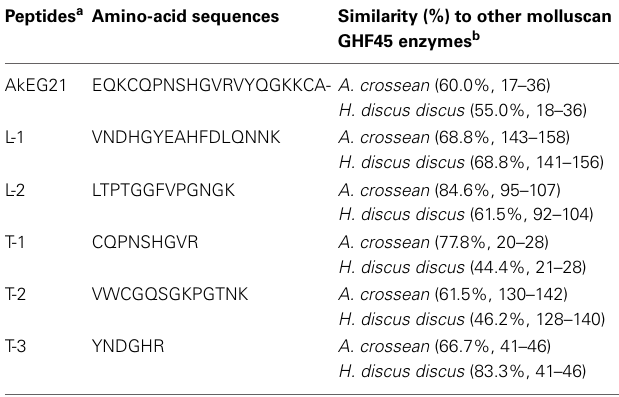
Table 2 | N-terminal and internal amino-acid sequences of AkEG21. Table 3 | Primers used for amplification of Peptides a Amino-acid sequences Similarity (%) to other molluscan GHF45 enzymes b